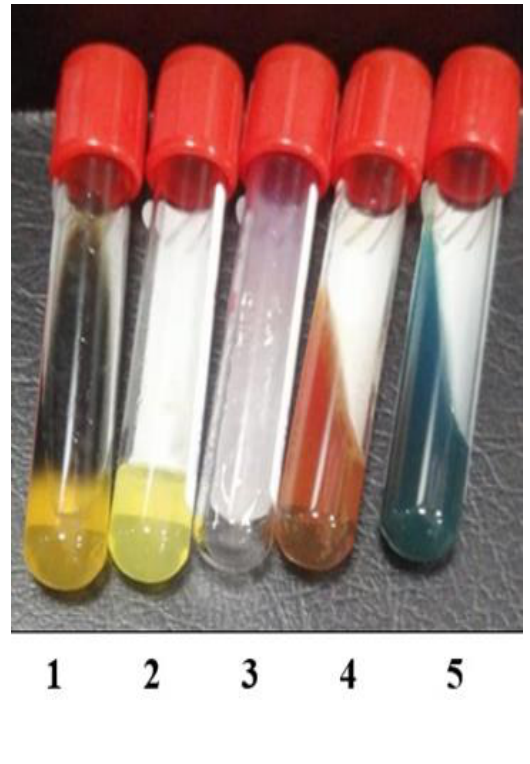
Figure 1. Results of biochemical reactions: 1: triple sugar iron (TSI), 2: urease, 3: motility indole ornithine medium (MIO), 4 : lysine iron agar (LIA) & 5: Citrate.